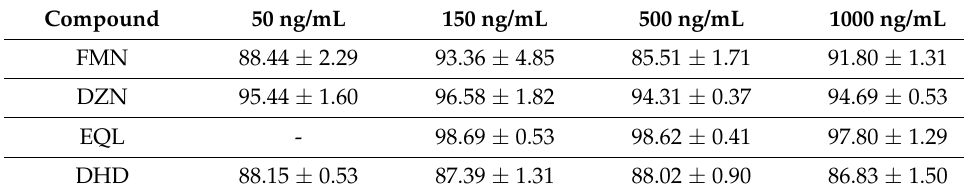
Table 2. Plasma protein binding assay result of FMN, DZN, EQL, and DHD.